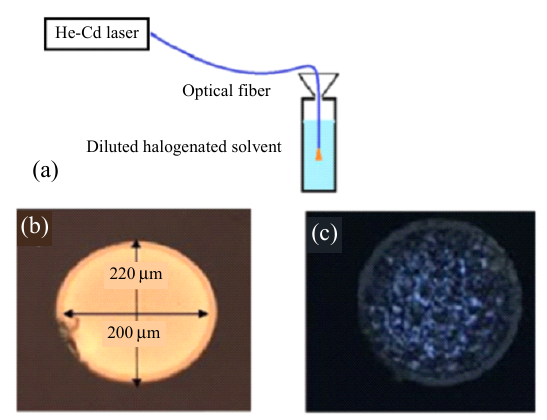
Fig. 1 Setup and microscopic observation of the fiber distal end: (a) schematic of UV-induced deposition on the optical fiber terminal end, (b) optical fiber transversal cross-section with a 200 μ m core and 220 μ m clad diameters, and (c) representation of the optical fiber terminal end after TPPS thin-film